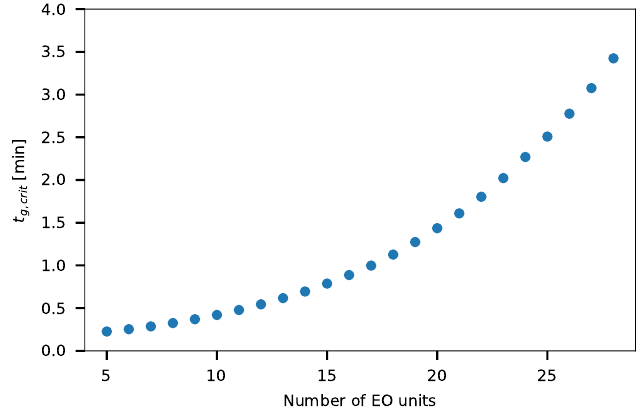
Figure 7. The critical gradient time of the Triton X-100 compounds with a different number of ethylene oxide units ( ∆ ϕ = 0.42 and ϕ 0 = 0).